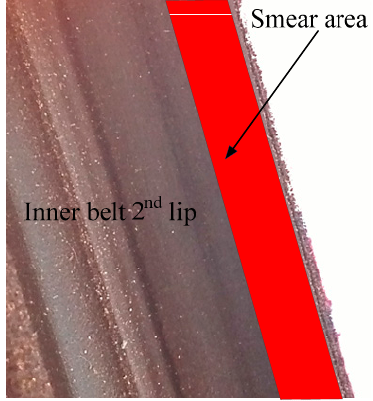
Figure 24. Smear area. The coating is MR3-800.